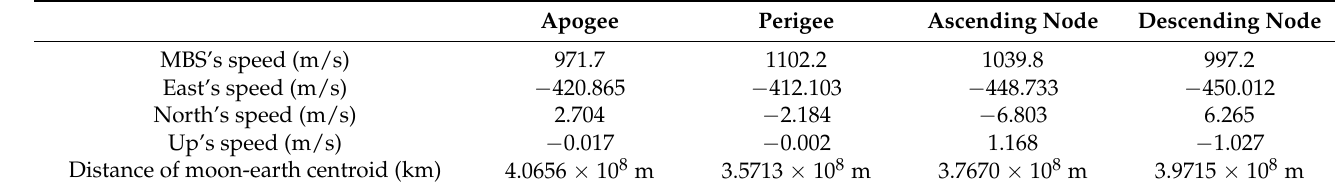
Table 6. The speed of MBS in ECR, the distance of Moon-Earth centroid, and the speed of corre- sponding sub-point in ENU orientation. The line parallel to latitude and direct to east is called “E” orientation; the line parallel to longitude and direct to north is called “N” orientation; and the other line that satisfies the right-hand rule with the “E” and “N” is called “U” orientation. The time of apogee, perigee, ascending, and descending nodes are consistent with the time in Tables 2 and 3. Apogee Perigee Ascending Node Descending Node 971.7